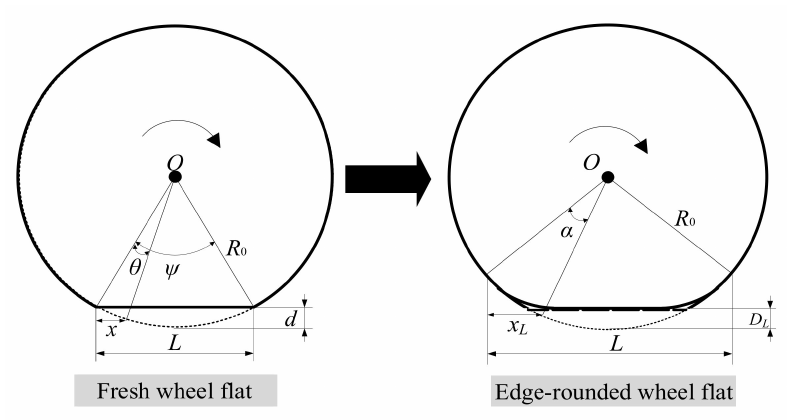
Figure 4. Geometric model of wheel